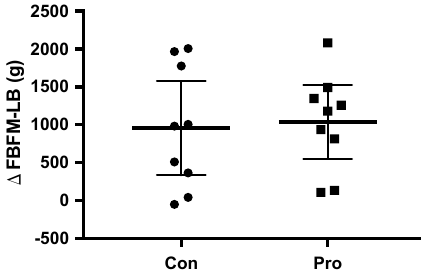
Figure 3. Con, control group; Pro, protein group. Individual and mean (95% confidence interval (CI)) changes in ∆ LB-FBFM from pre to post. Dots represent Con (Con; n = 9), and boxes represent Pro (Pro; n =